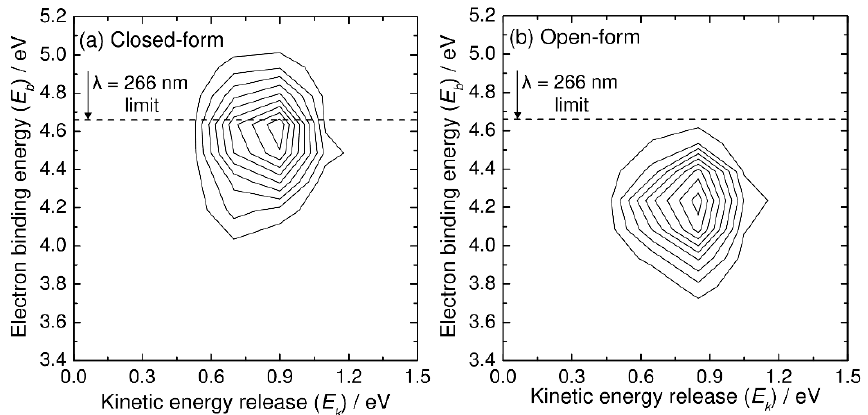
Figure 4. N ( E k , E b ) two-dimensional correlation spectra for C 2 O 4 H − + h ν → CO 2 + HOCO + e − , where E k and E b are the relative kinetic energy between the CO 2 and HOCO fragments and electron binding energy, respectively. Results from the RPMD calculations at T = 300 K for ( a ) closed-form and ( b ) open-form C 2 O 4 H − .